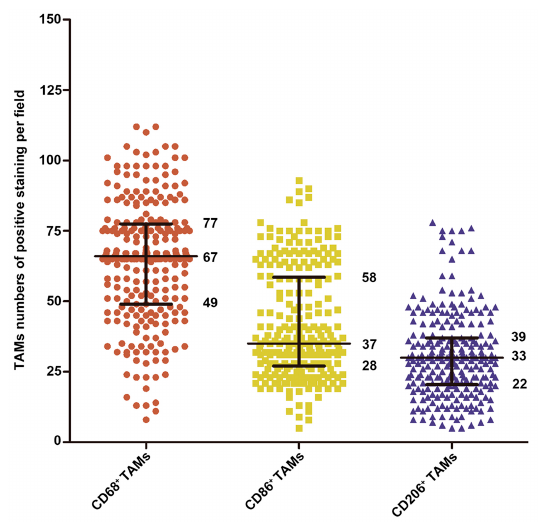
Figure 2. The number distribution of CD68 + , CD86 + and CD206 + macrophages in the cohort ( n = 253). Lines indicated 25th, 50th, and 75th percentiles. TAMs: Tumor-associated macrophages.